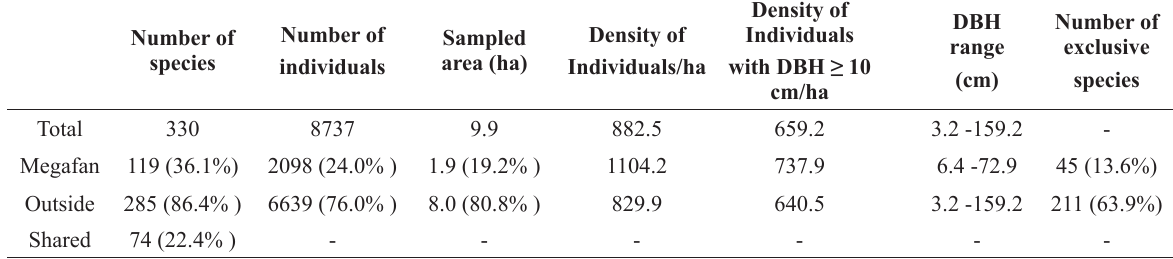
Summary of data collected on eleven tree plots in the megafan sediment and nine tree plots in older basement rocks. Shared species are those found in both areas.